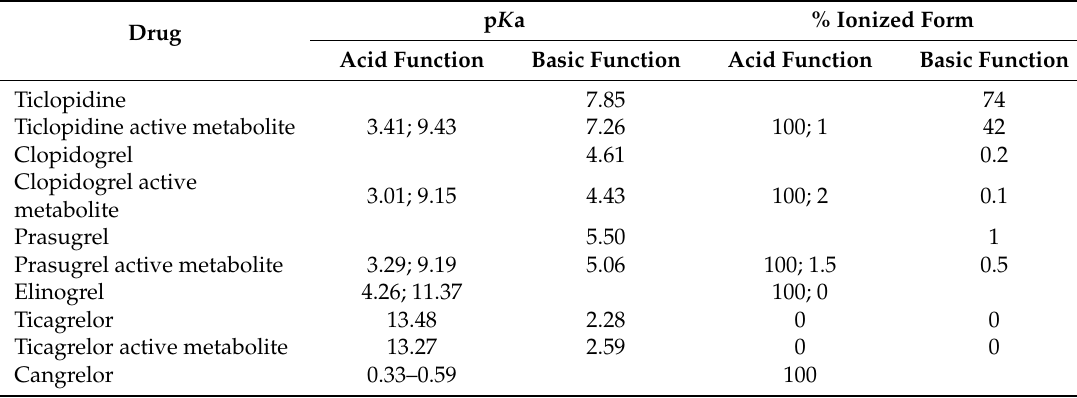
Table 4. Calculated p K a values (at 25 ˝ C) of the antiplatelet drugs